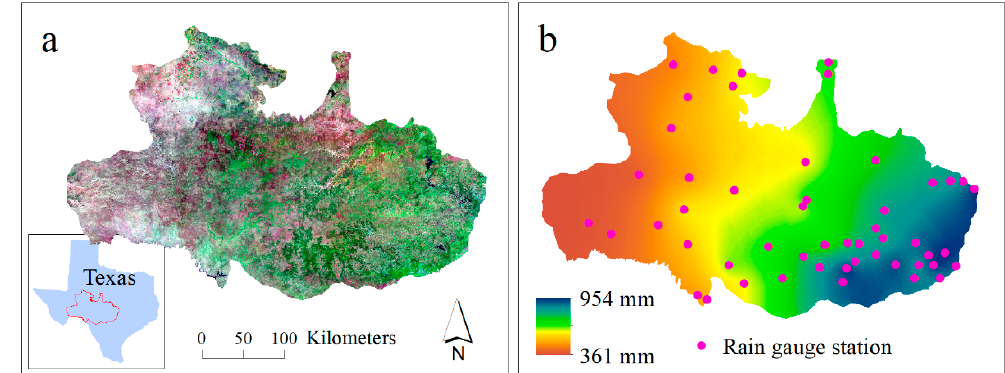
Figure 1. ( a ) The study area of Texas savanna in central Texas, USA, displayed with Landsat GeoCover Mosaics of 2000 in a natural-like rendition; ( b ) distribution of rain gauge stations and the interpolated mean annual precipitation surface.